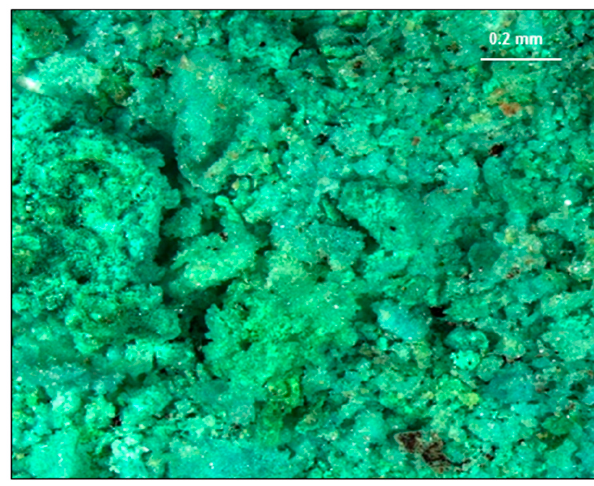
Figure 6. Stereomicroscope image of pale green antlerite.